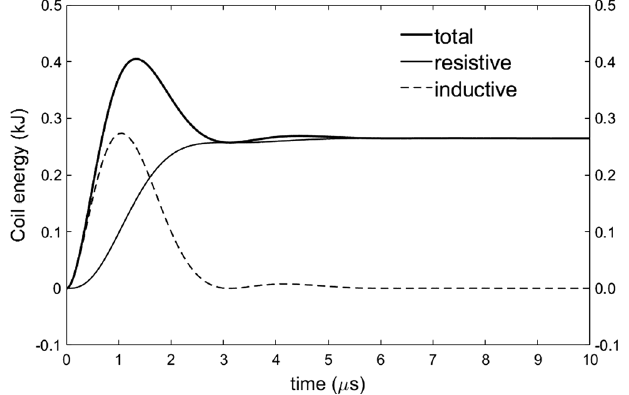
FIG. 5. MIFEDS-3 coil peak current (asterisk) and time-to-peak current (times) calculations as a function of coil inductance. The coil resistance is assumed to be 20 m Ω for all